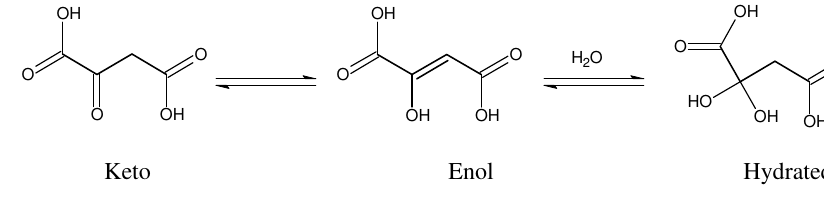
Fig. 2. The three forms of oxosuccinic acid in aqueous solution.